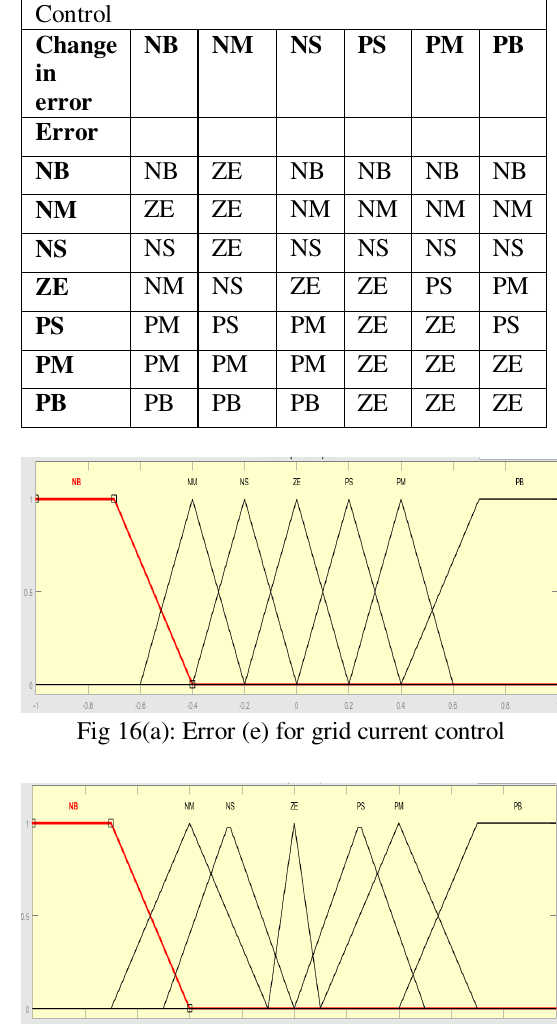
Table 3: Fuzzy Rule Base for DC-link Voltage